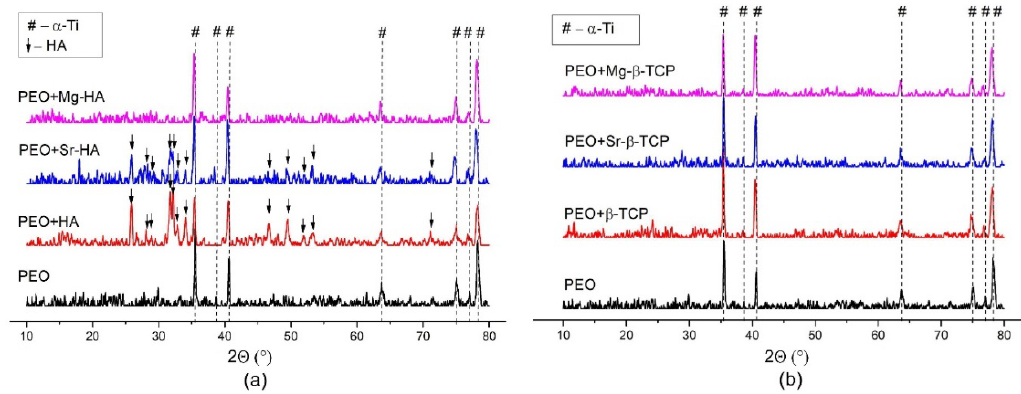
Figure 3. XRD patterns of CaP PEO and composite PEO + RF coatings sputtered with ( a ) HA, Sr-HA, Mg-HA; ( b ) β -TCP, Sr- β -TCP, Mg- β -TCP targets.